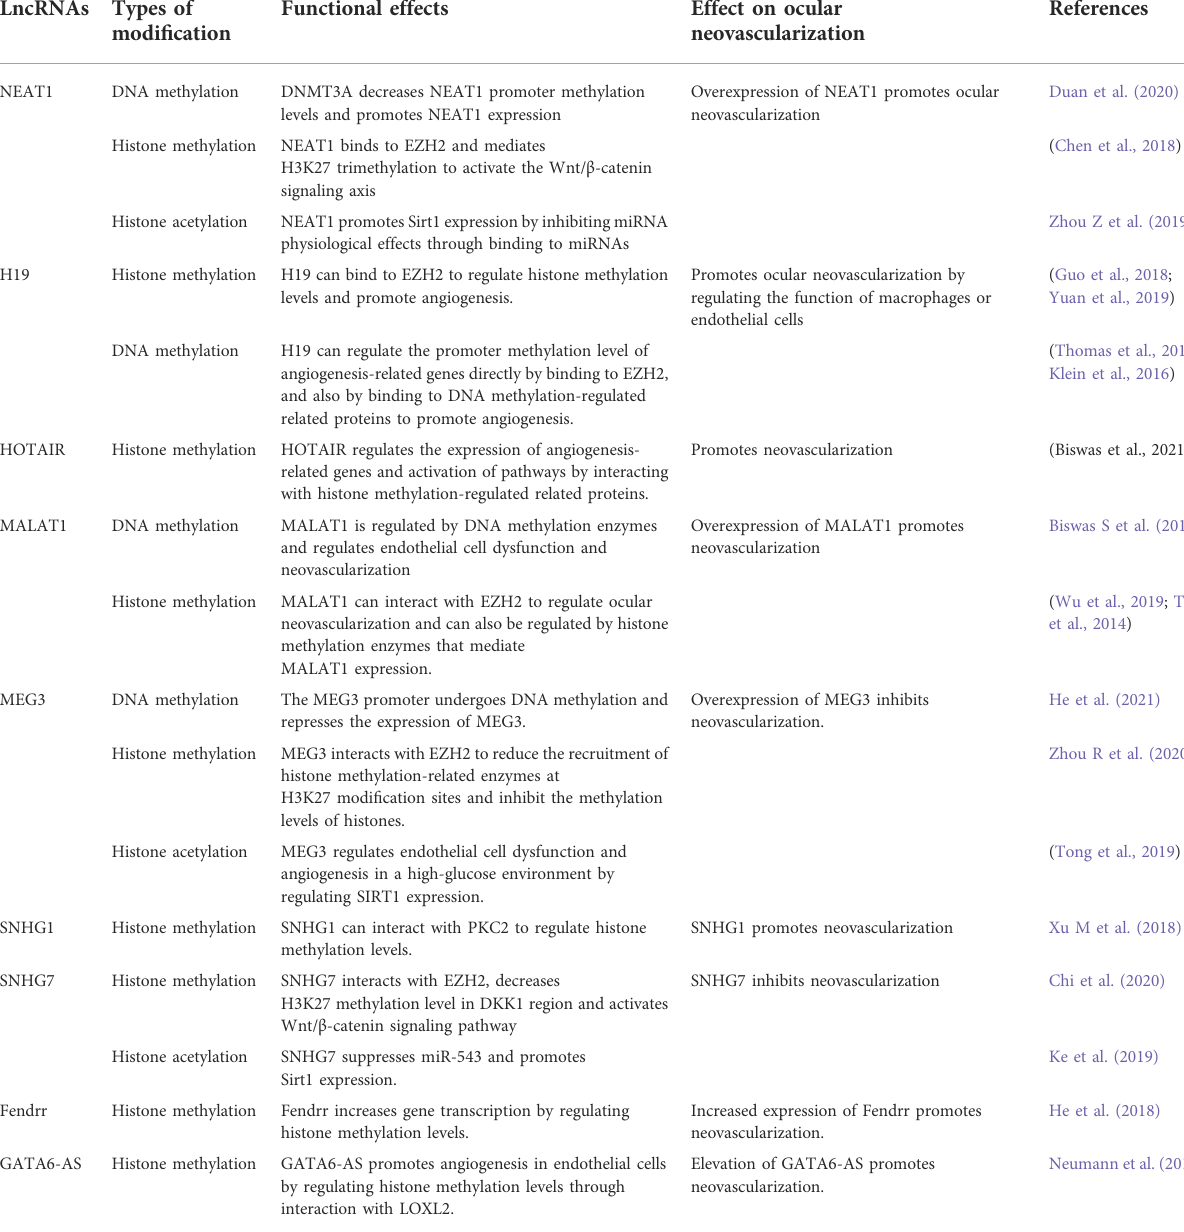
TABLE 4 Potential epigenetic regulatory networks involving ocular neovascular